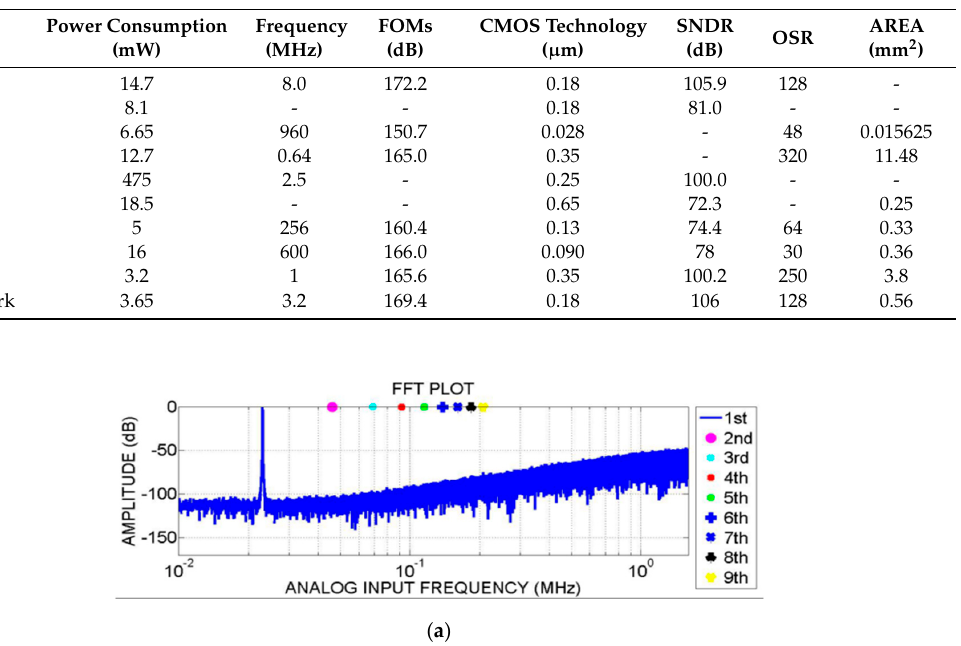
Table 2. Parameter comparison.